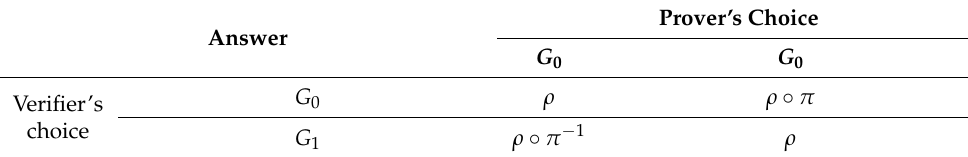
Table 3. The response of prover.